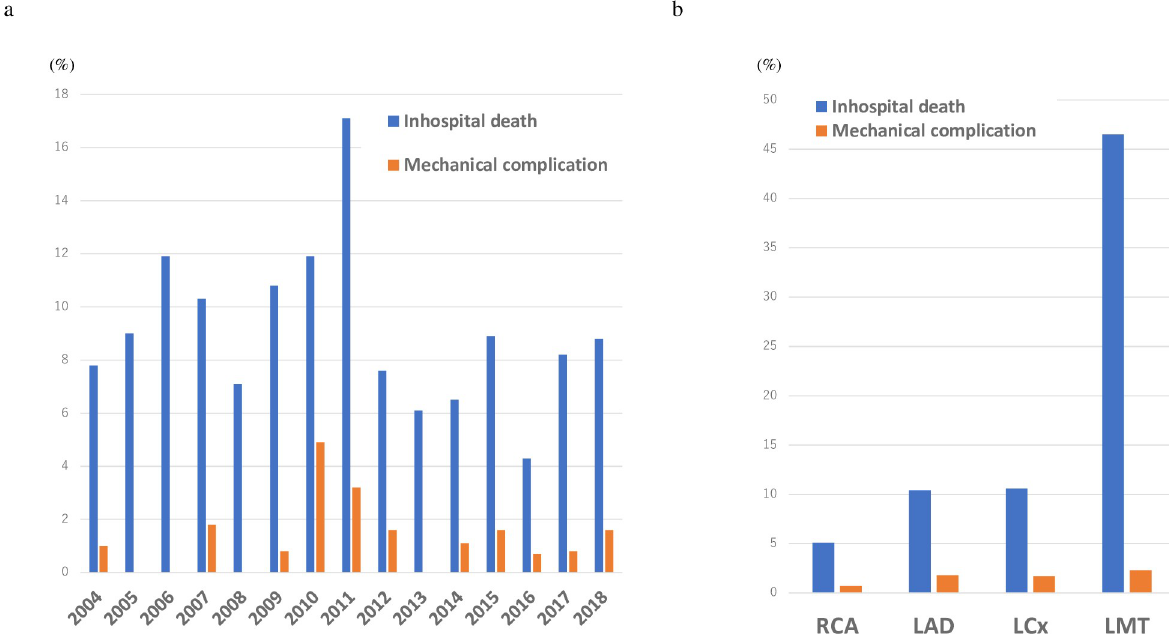
Fig 2. In-hospital outcome according to procedural year (a) and culprit vessels (b). RCA, right coronary artery; LAD, left anterior descending artery; LCx, left circumflex artery; LMT, left main trunk.